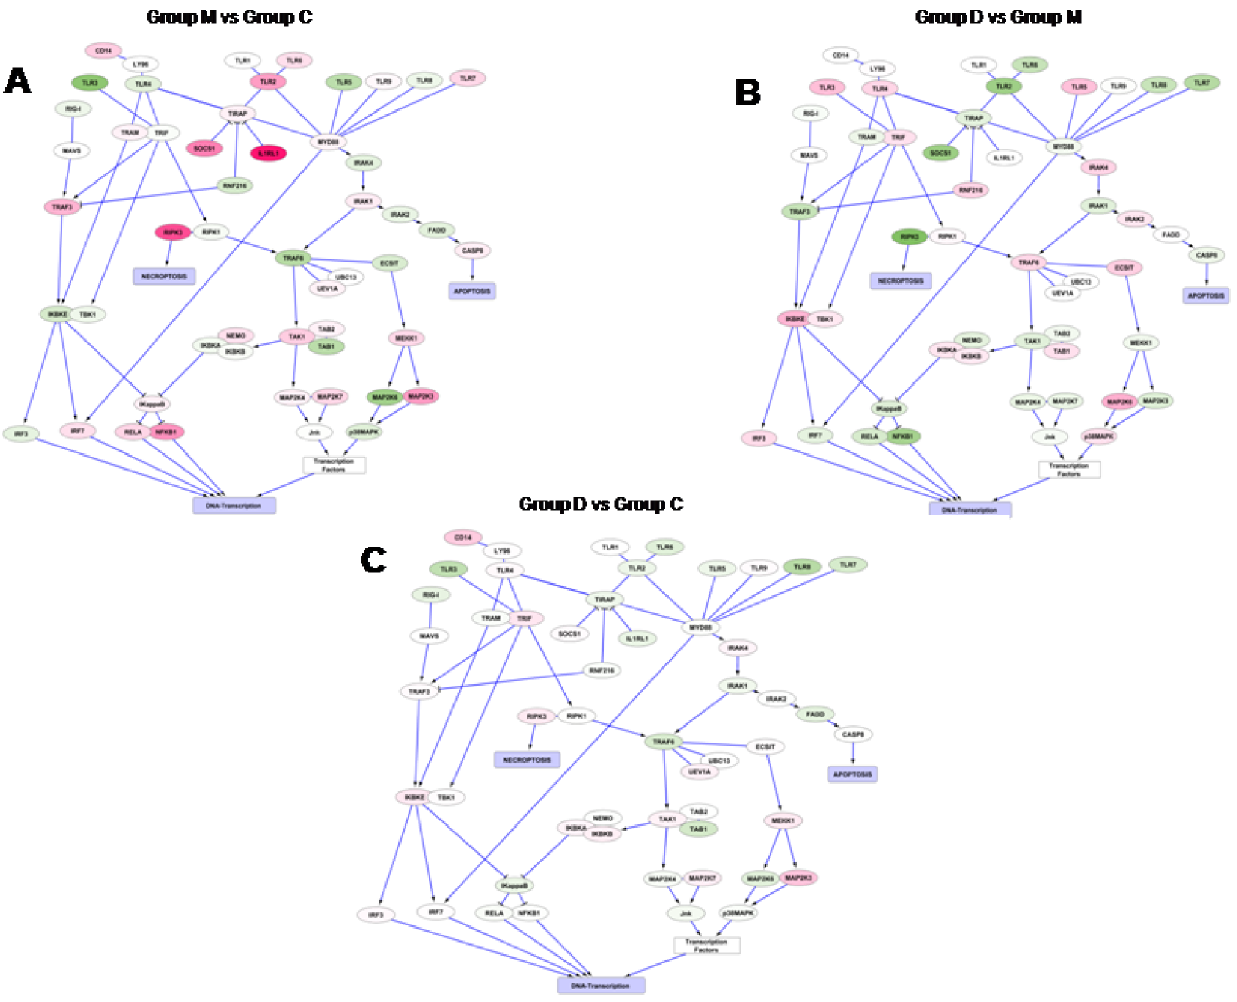
Figure 8. Interaction network: core inflammatory pathway. (A–B) The expression of several genes of the pro-inflammatory pathways which were upregulated (red color) or downregulated (green color) in group M compared with group C was neutralized upon treatment with the probiotic diet. This effect was observed for both receptors expressed on the cell surface and components of various signal transduction cascades including NF kB, IRFs and MAPK pathways. (C) VSL # 3 almost completely restored the initial pattern of inflammation-related genes.